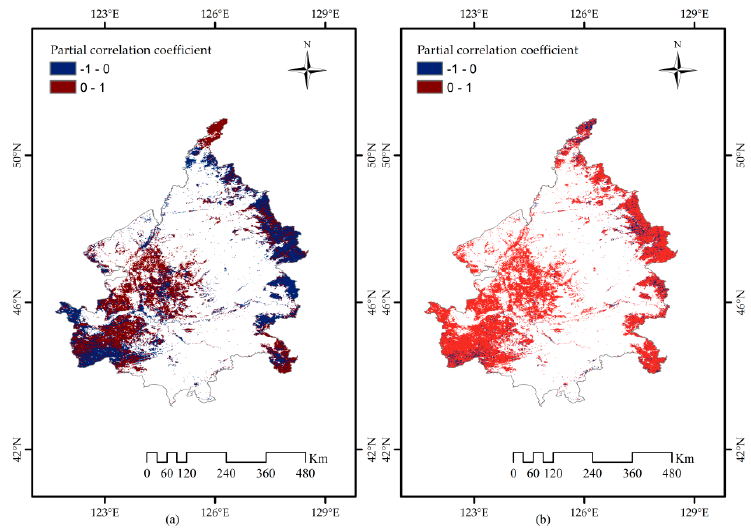
Figure 12. Partial correlation coefficients between CUE and major climatic factors in the growing season: ( a ) precipitation; ( b ) temperature.